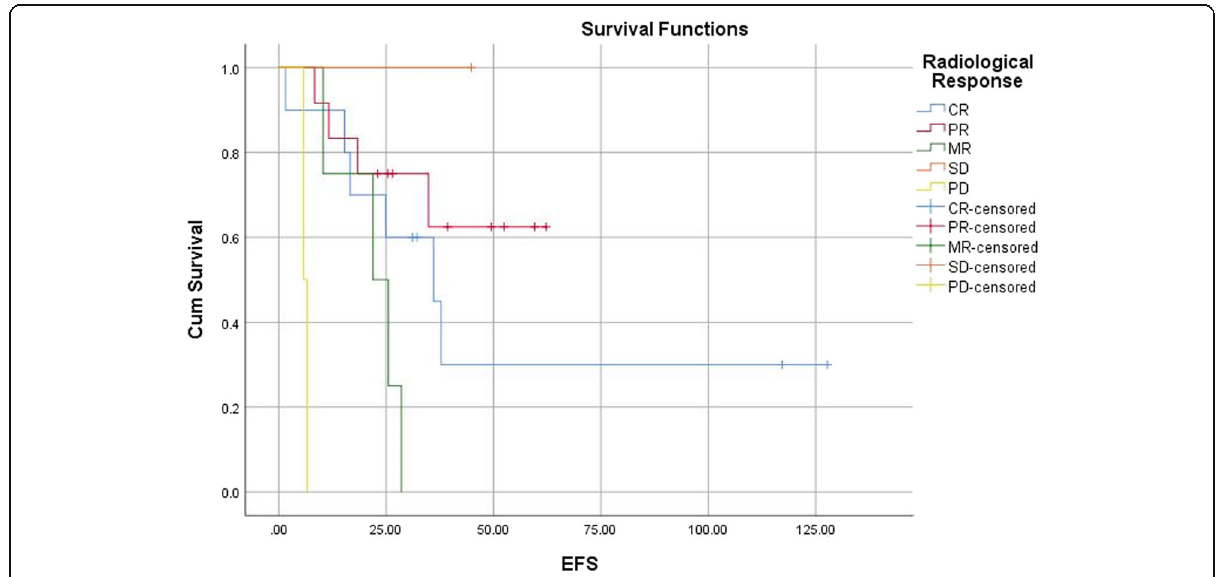
Fig. 3 Correlation between radiological response post-induction and event-free